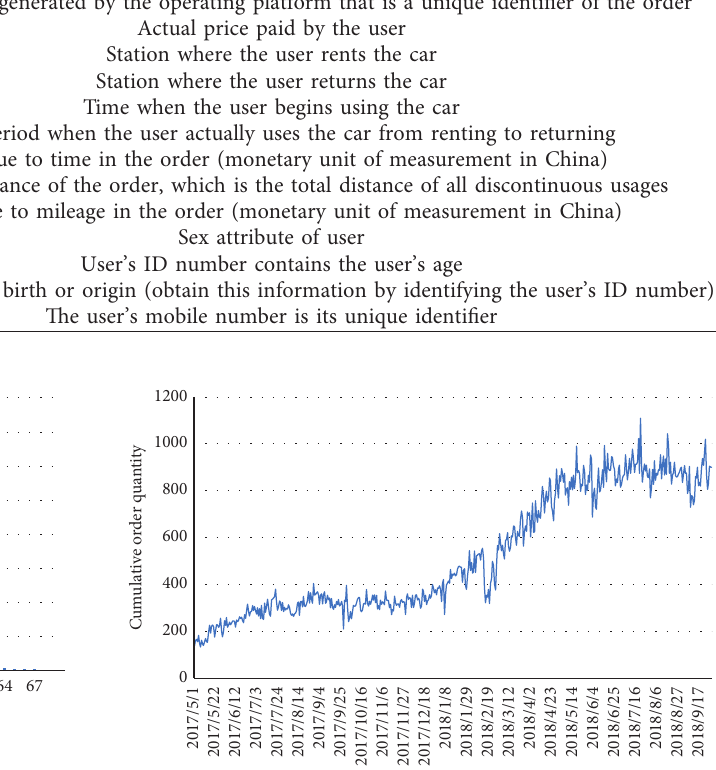
Figure 3: Daily order quantity trend.